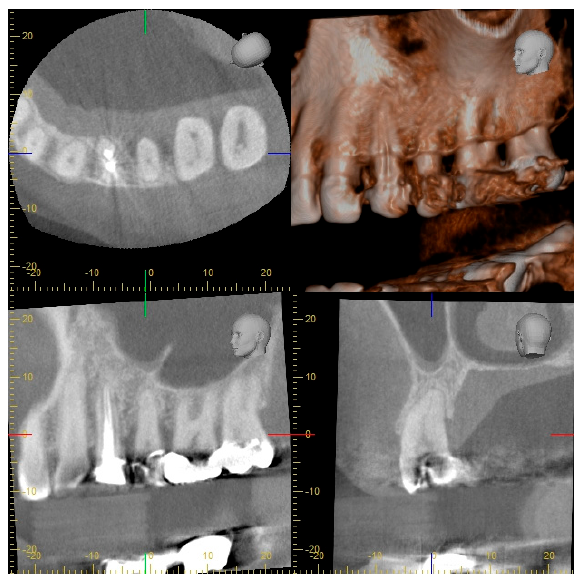
Figure 3. Part of full-mouth cone beam computed tomography (CBCT) with horizontal, sagittal and transversal sections of the first and second left maxillary premolars and molars.